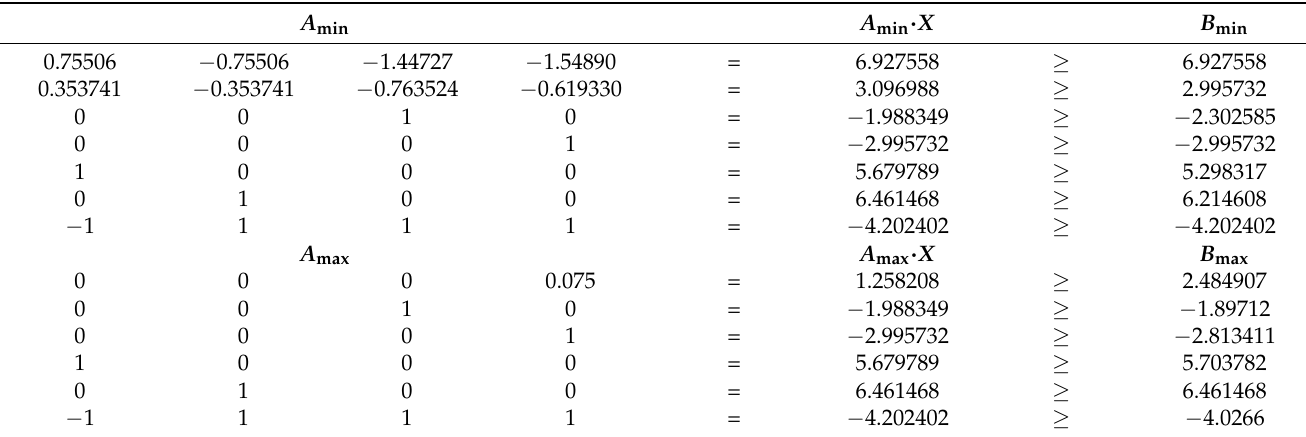
Table 7. Solving the optimization problem using linear programming.